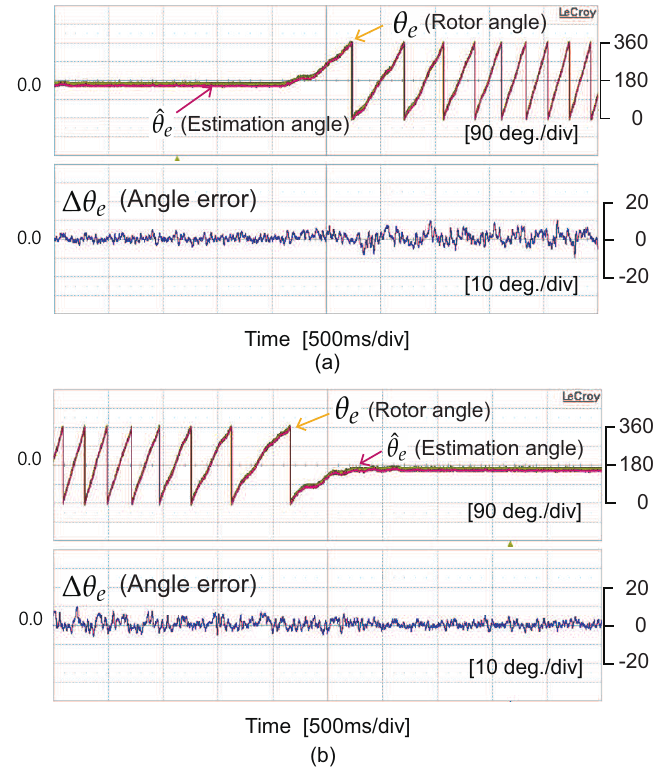
= − 20 A, i e = 50 A): q d